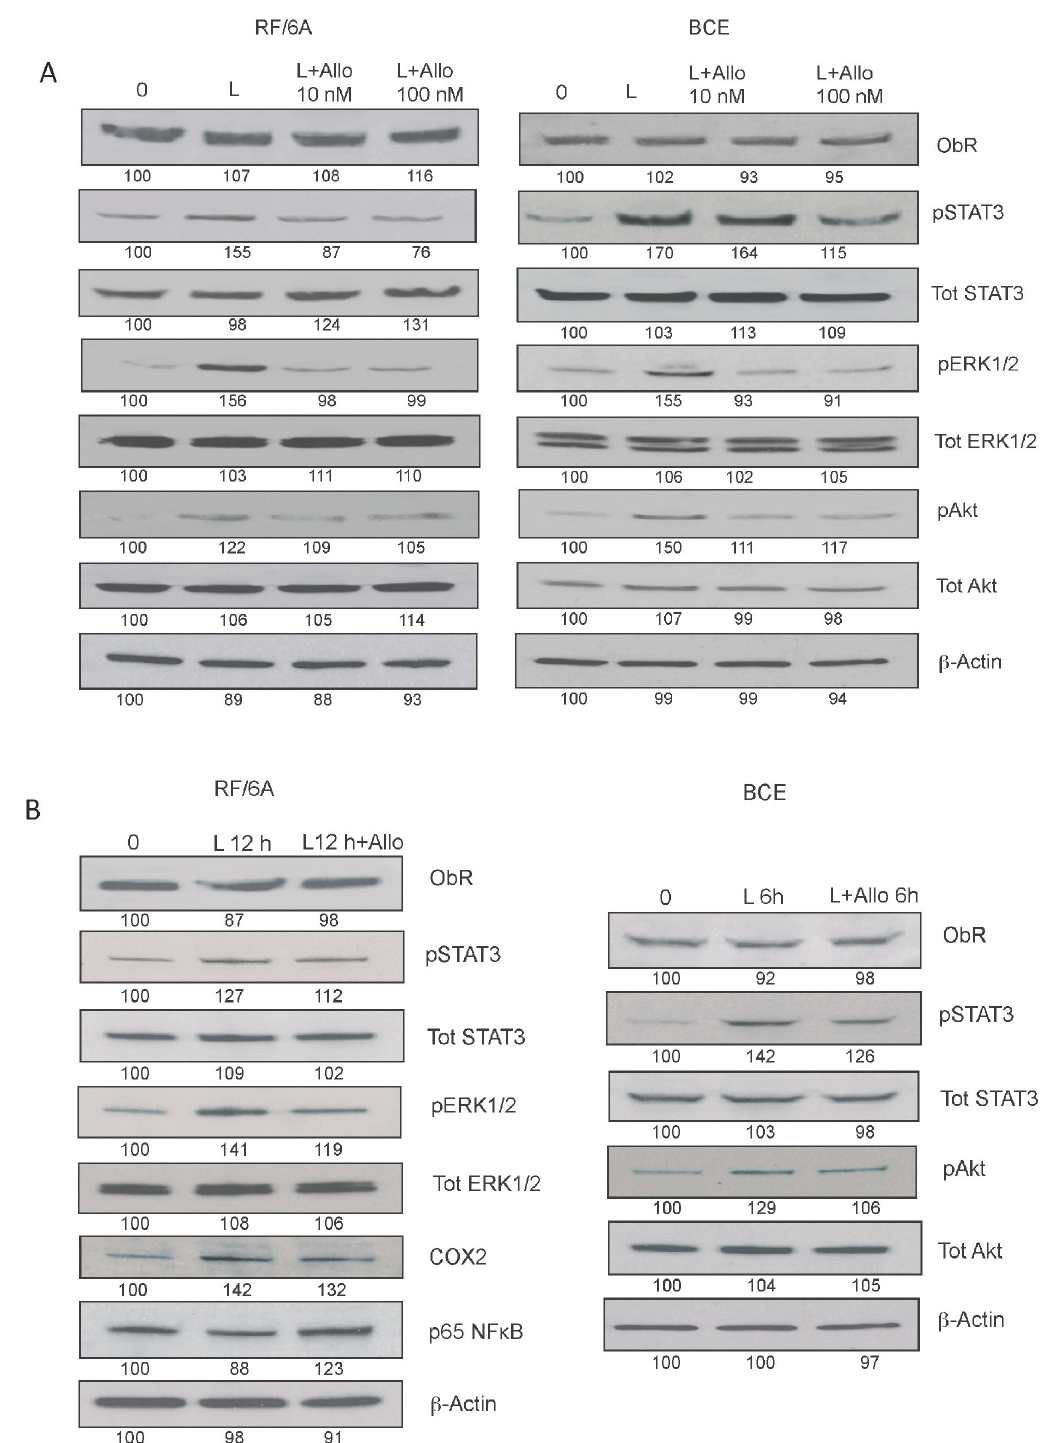
Figure 7. Effects of Allo-aca on intracellular leptin effects in RF/6A and BCE cells. A . The effects of 10 and 100 nM Allo-aca (Allo) on acute intracellular signaling were tested in RF/6A and BCE cells stimulated with 250 ng/mL leptin (L) for 30 min. B . The long-term effects of 100 nM Allo-aca (Allo) on intracellular pathways were assessed in cells stimulated for 12 h (RF/6A) or 6 h (BCE) with 250 ng/mL leptin (L) and measured as described under Figures 5 and 6. The representative blots of at least 3 experiments are shown. doi: 10.1371/journal.pone.0076437.g007 PLOS ONE |